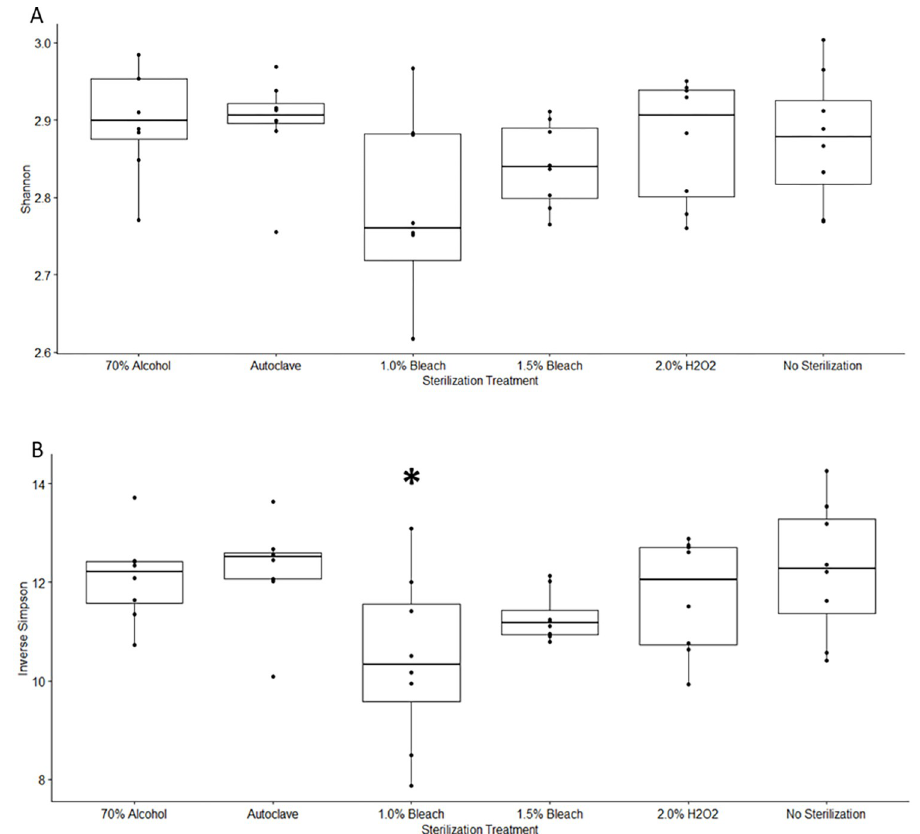
Fig 6. Shannon and Inverse Simpson diversity of simulated in vitro colonic fermentation of six different pulse flour treatments. Each treatment includes all four pulse types. (A) Shannon index, pairwise comparison of each treatment against untreated. (B) Inverse Simpson index, pairwise comparison of each treatment against untreated. � indicates p < 0.05.